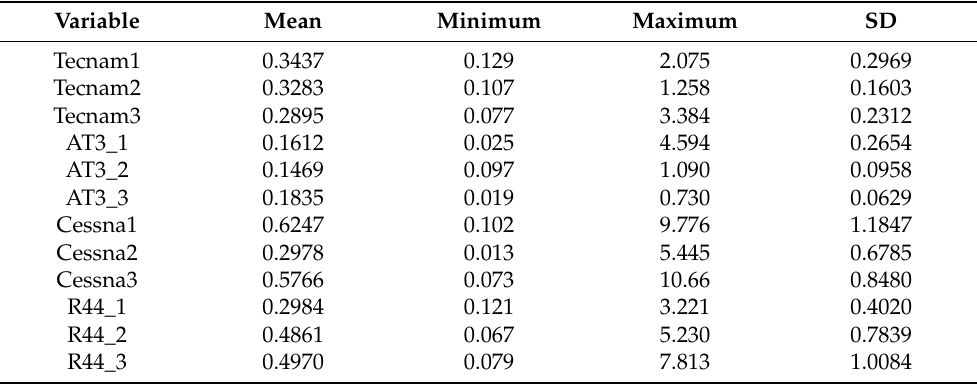
Table 3. Characteristics of the intensity of the electrical component of the electromagnetic energy E , in V/m, for testing